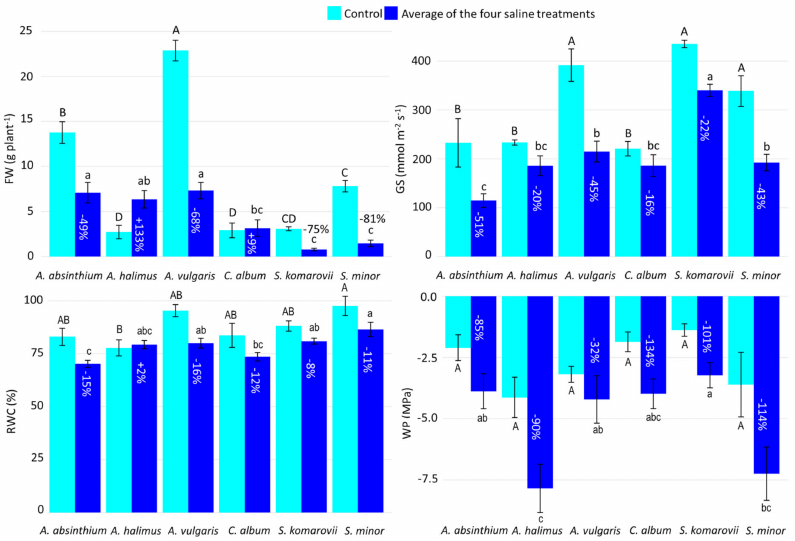
Figure 1. Fresh weight (FW), stomatal conductance (GS), leaf relative water content (RWC), and leaf water potential (WP) of the six halophyte species under control (cyan histograms), and the four saline treatments combined (blue histograms). The percent difference between control and the combined saline treatment is reported for each species as % in the saline treatment column. Uppercase and lowercase letters indicate statistical differences ( p ≤ 0.05) among the six species in controls and average saline treatment respectively. Vertical bars indicate ± one standard